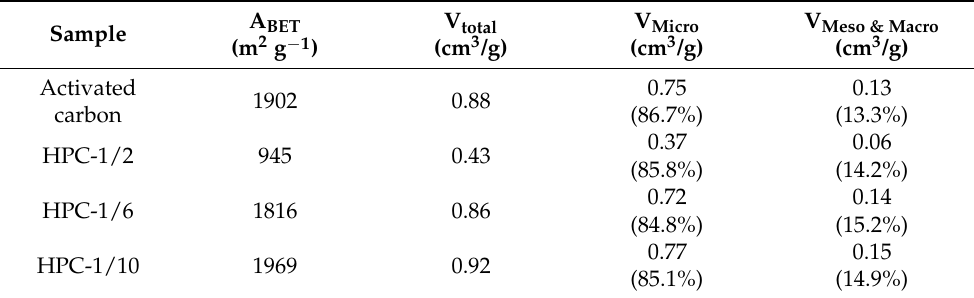
Table 1. Specific surface area (A BET ), various types of pore volume of activated carbon, HPC-1/2, HPC-1/6, and